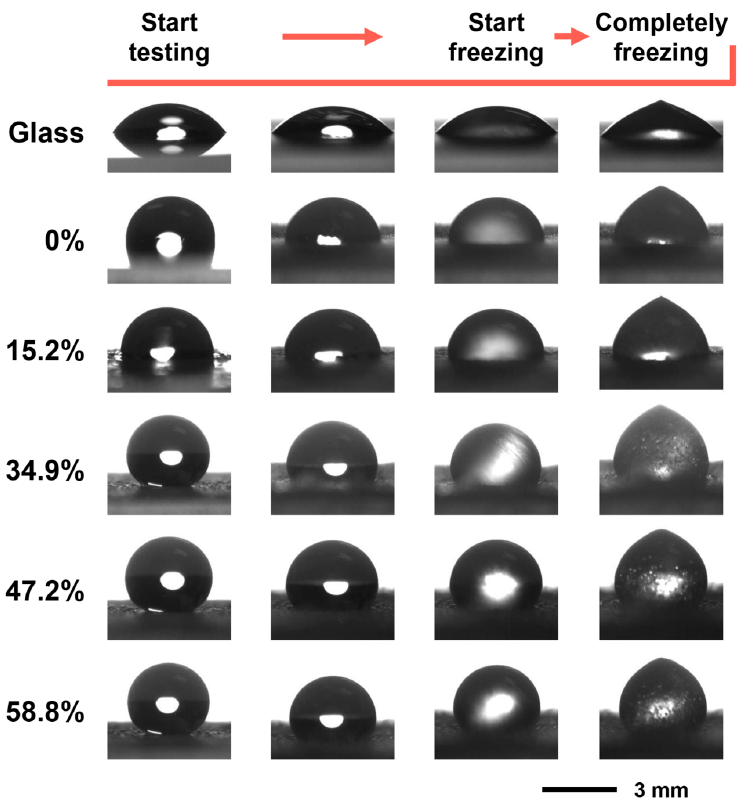
Figure 6. Freezing process of water droplets placed on glass and coatings with different PTFE mass fractions.